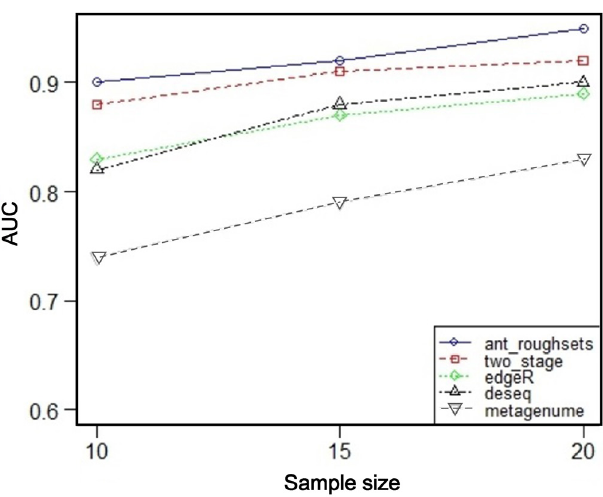
Fig. 7. Comparison of AUC curves.